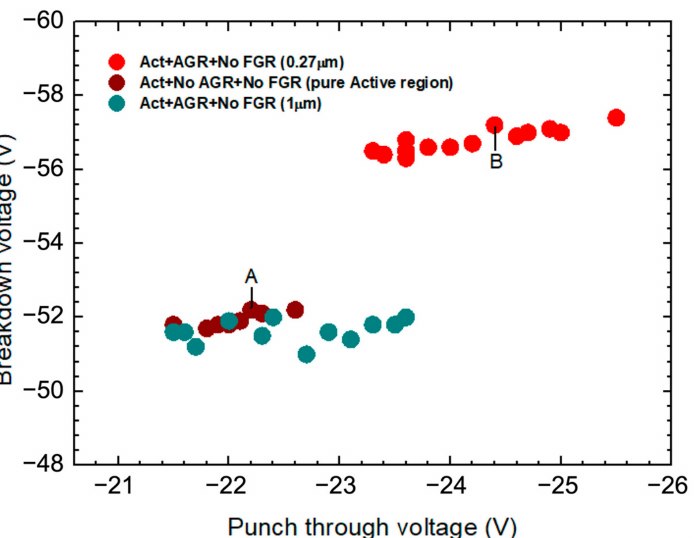
Figure 5. Breakdown voltages of devices with optimal AGR (red), without AGR (brown), and with shallower AGR (green), as functions of punch-through voltages. The depth of the optimal AGR is shallower than that of the central active region by 0.27 µ m, while the depth of the shallower AGR is shallower than that of central active region by 1 µ m. The brown circle marked “A,” and the red circle marked “B” are device A and B, respectively, in Figure